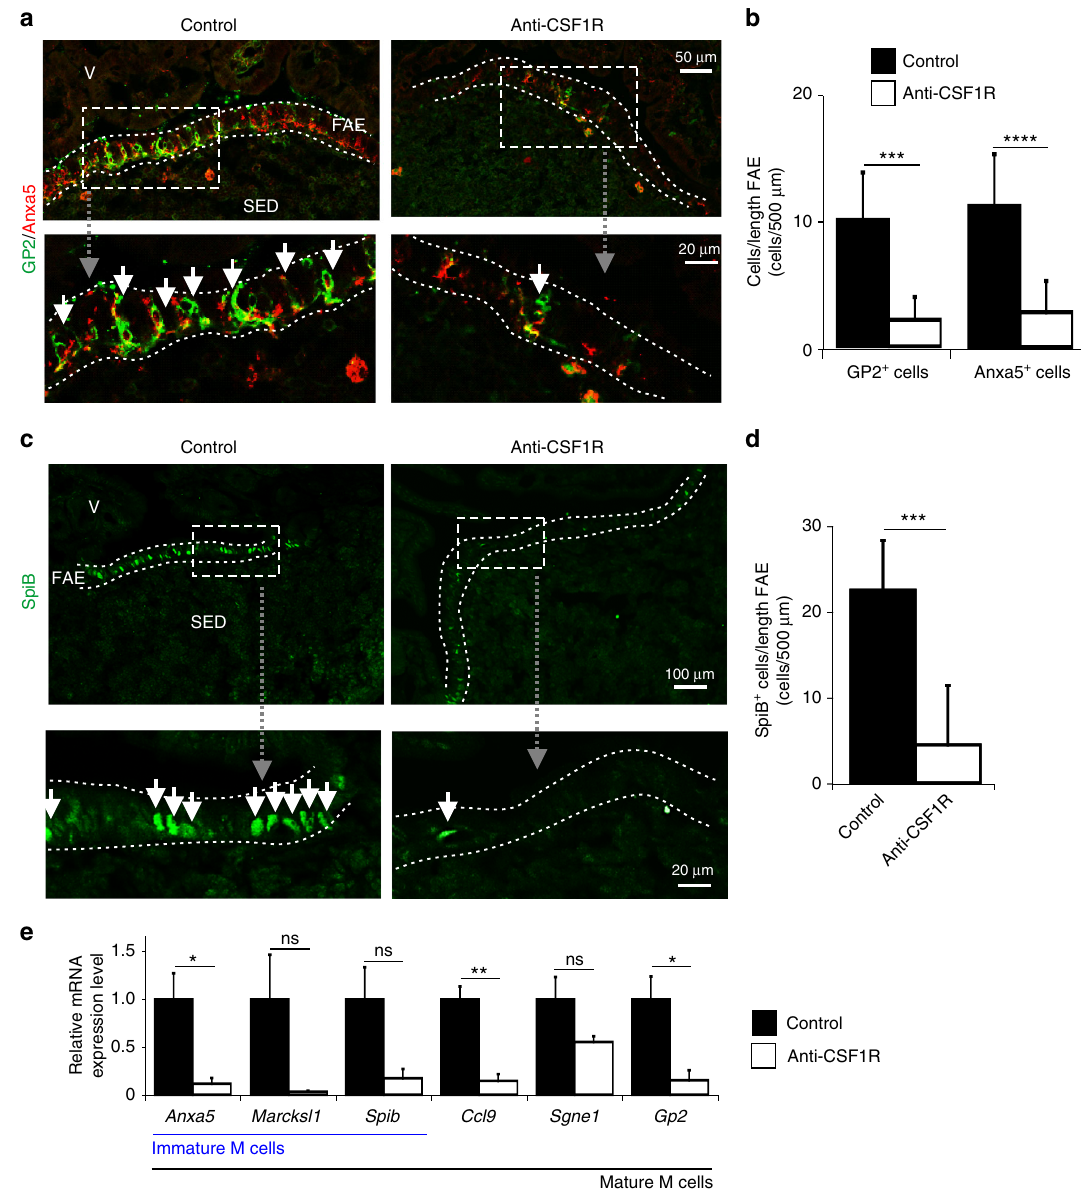
Fig. 8 Loss of immature and mature M-cell marker expression in Peyer ’ s patches after prolonged CSF1R blockade. Mice were treated with anti-CSF1R mAb or control-IgG (control) for 6 weeks before subsequent analysis. a Detection of Anxa5 (red) and GP2 (green) in the follicle-associated epithelium (FAE) by IHC. Scale bar, upper panels, 50 µ m. Scale bar, lower panel, 20 µ m. b Morphometric analysis of the number of GP2 + and Anxa5 + M cells in the FAE. SED, subepithelial dome. Data represent mean ± SD from 1 to 7 FAE from 8 mice/group. ***, P < 0.001, two-tailed unpaired Student ’ s t -test; **** P < 0.001, Mann – Whitney U -test. c IHC analysis of SpiB expression (green) in the FAE. Dotted line in A & C shows the FAE boundary. Scale bar, upper panels, 100 µ m. Scale bar, lower panel, 20 µ m. d Morphometric analysis of the number of SpiB + cells in the FAE. Data represent mean ± SD from 6 to 9 FAE from four mice/group. ***, P < 0.001, Mann – Whitney U -test. e RT – qPCR analysis shows the expression of immature ( Anxa5 , Marcksl1 , and Spib ) and mature ( Ccl9 , Sgne1 , and Gp2 ) M cell-related genes was reduced in Peyer ’ s patches after prolonged CSF1R blockade. Bars represent mean ± SEM derived from four mice/ group. * P < 0.05; ** P < 0.01, two-tailed unpaired Student ’ s t -test. NS not signi fi